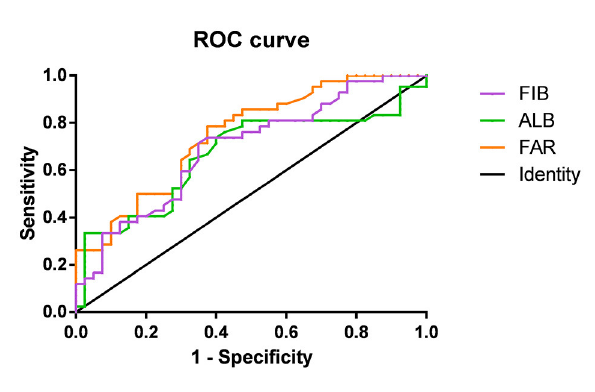
FIGURE2 Receiver-operating characteristic (ROC) curves showing the association between fibrinogen (FIB; purple), albumin (ALB; green), FIB-to-ALB ratio (FAR; orange), and the severity of neurological dysfunction at the onset of MOG-IgG–Associated Disorders